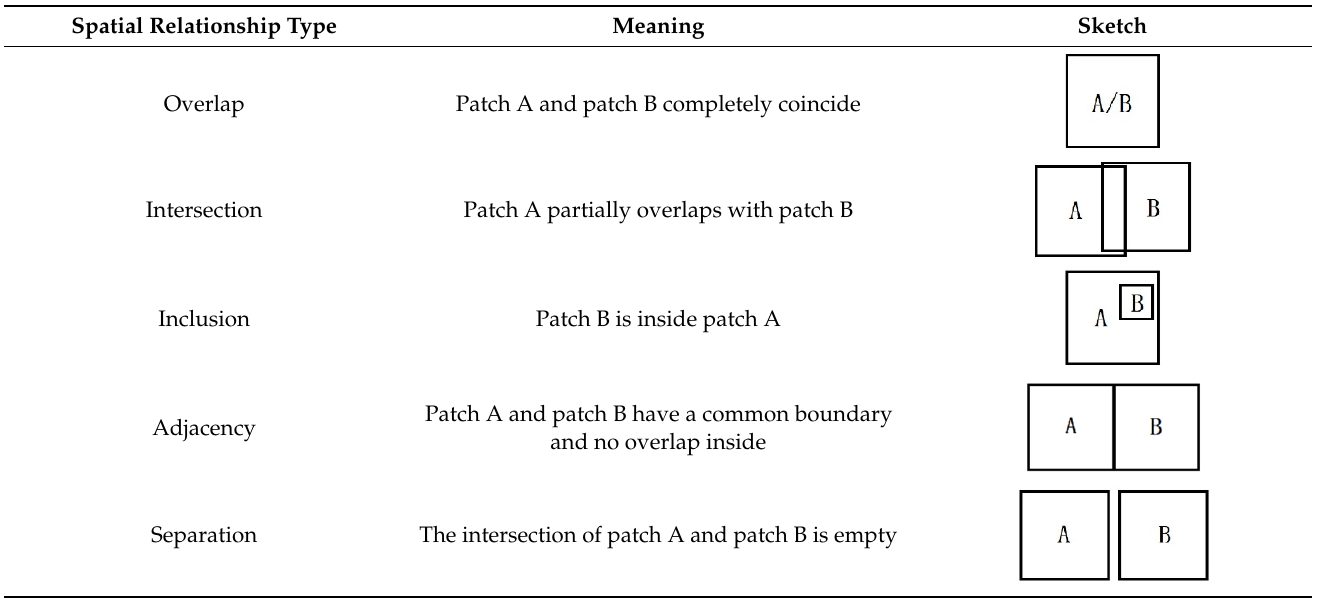
Table 1. Spatial relationship types of sea area use change patches and planning blueprint patches.